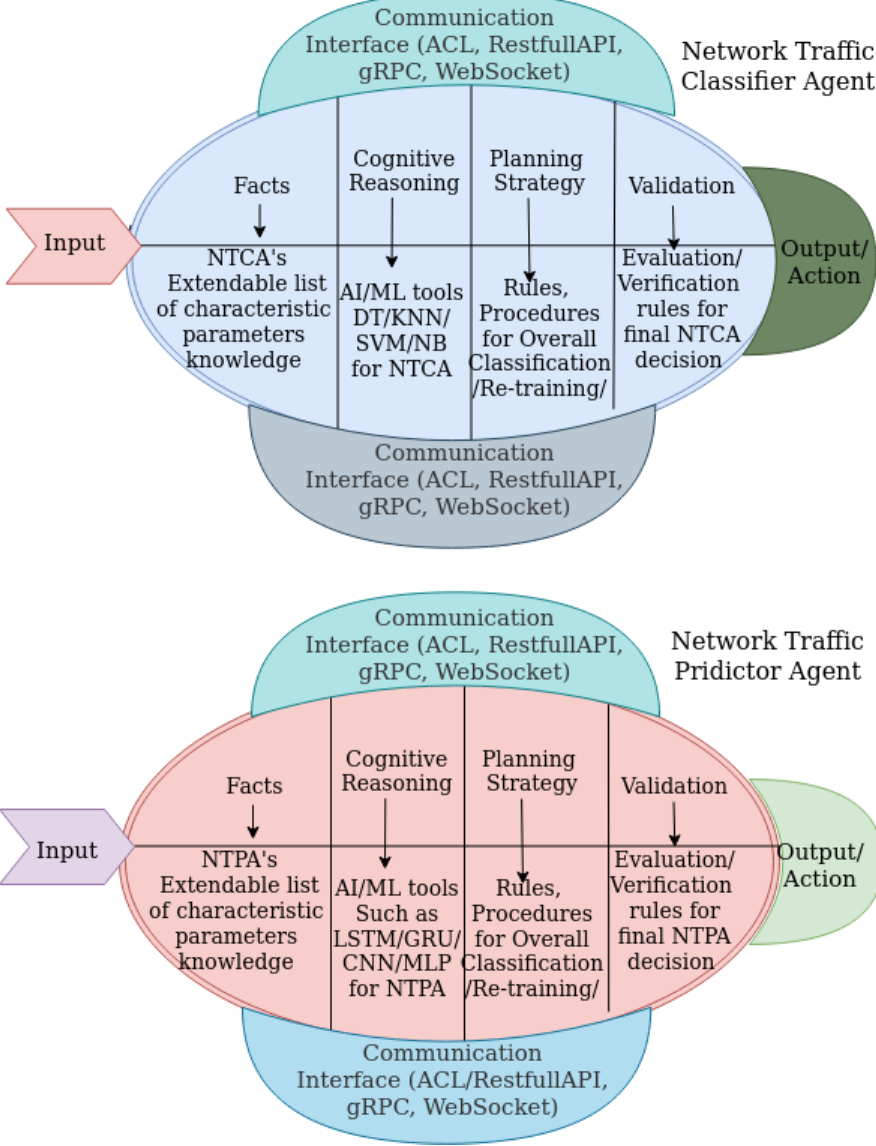
Figure 5. Network traffic classifier agent ( top ) and network traffic predictor ( bottom ) agent